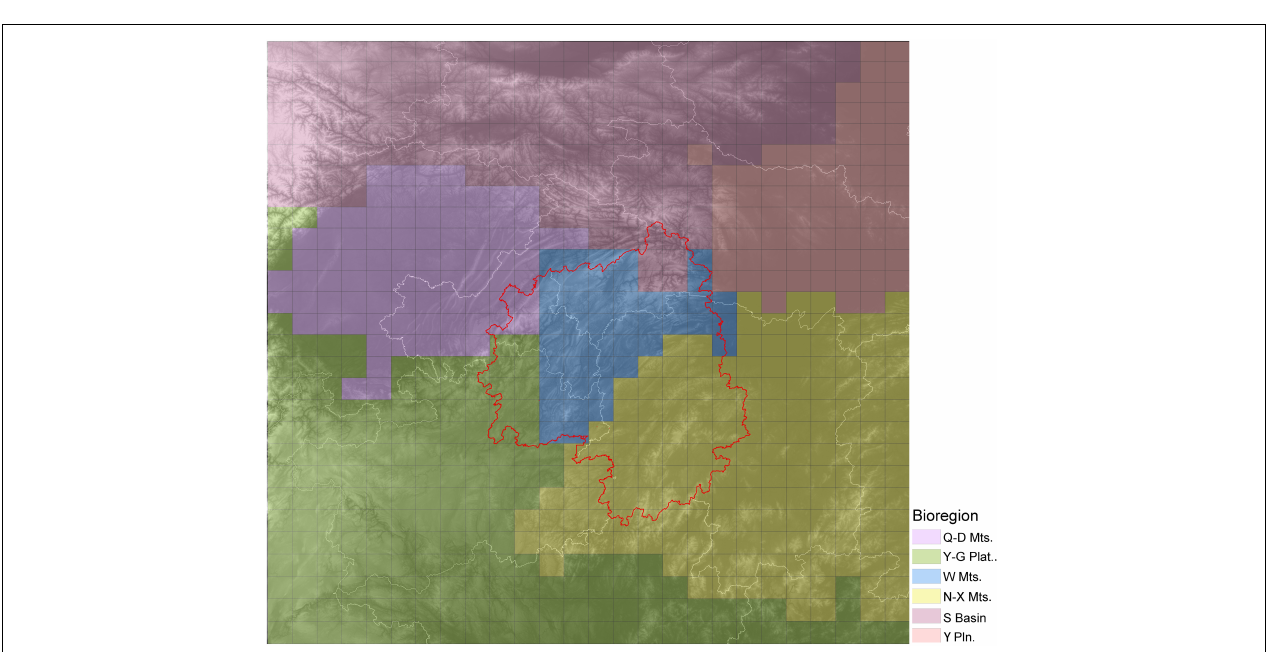
FIGURE 4 | Relationship between β -diversity and distance for different directions: (A) longitudinal (k1000 = 0.4732) and (B) latitudinal (k1000 = 0.4153).